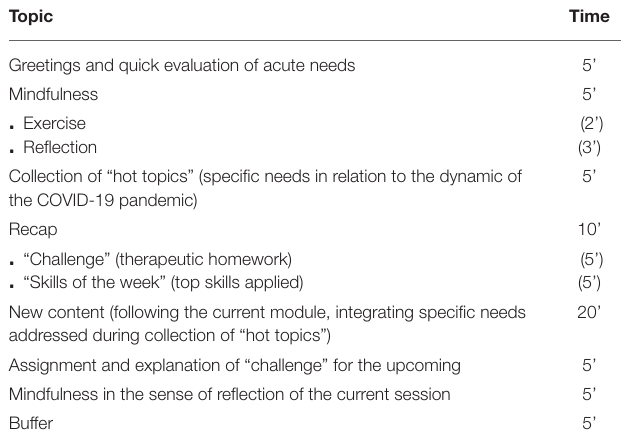
TABLE 1 | Session